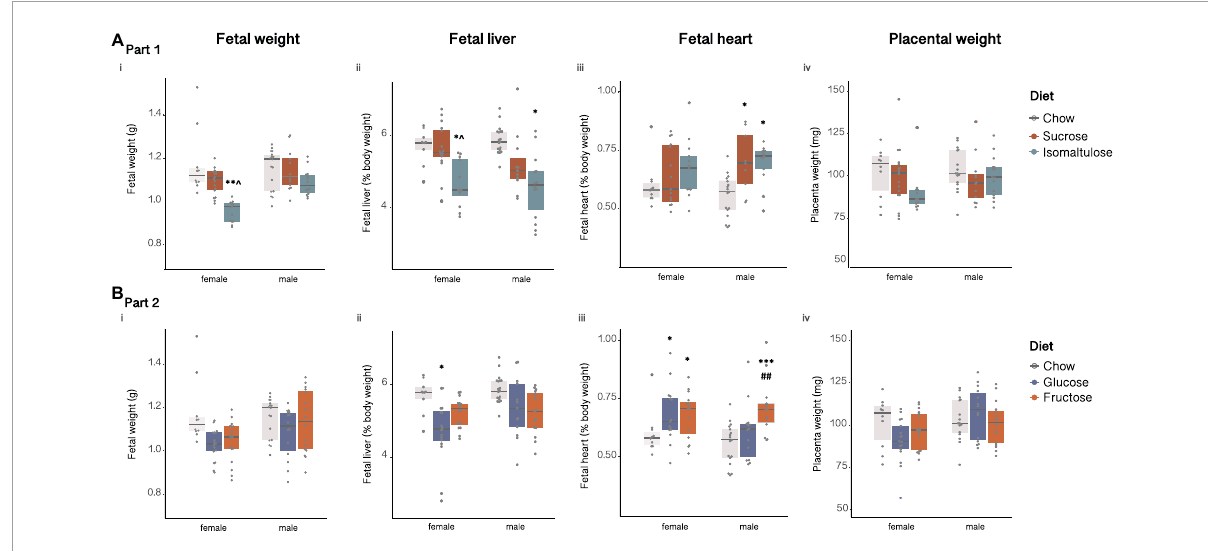
FIGURE4 Female and male fetal (A) in Part 1 and (B) in Part 2: (i) body weight, (ii) percentage liver weight, (iii) percentage heart weight and, (iv) placental weight. n = 9–18 per diet per sex. * p < 0.05 vs. chow; ** p < 0.01 vs. chow; *** p < 0.001 vs. chow; ˆ p < 0.05 vs. sucrose; ## p < 0.01 vs. glucose.